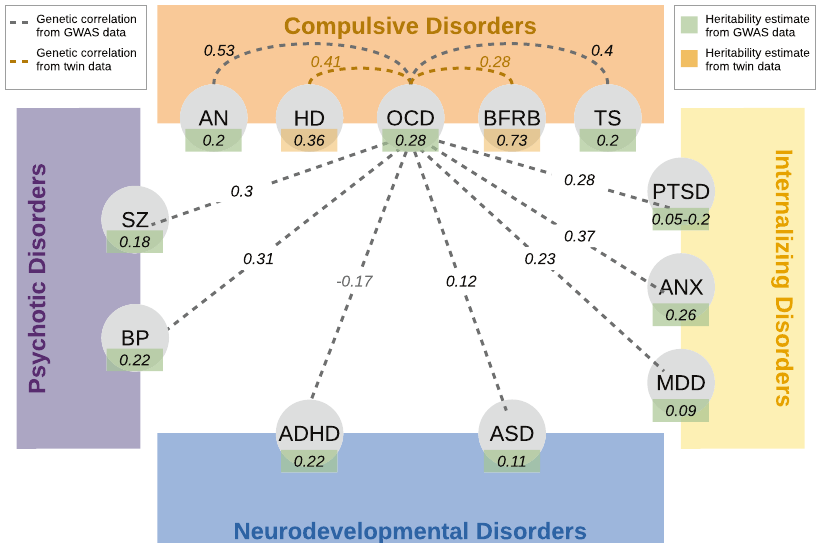
Fig. 4 Heritability estimates and genetic correlation estimates between OCD and related psychiatric disorders. For SZ, MDD, BP, ADHD, TS, AN, ANX, and PTSD heritability estimates (green boxes) and genetic correlations (black lines) were calculated using genome-wide data [80, 81, 117, 118, 121]. Whereas heritability estimates (pink boxes) and genetic correlations (orange lines) for HD [76, 113] and BFRBs [106] were calculated using